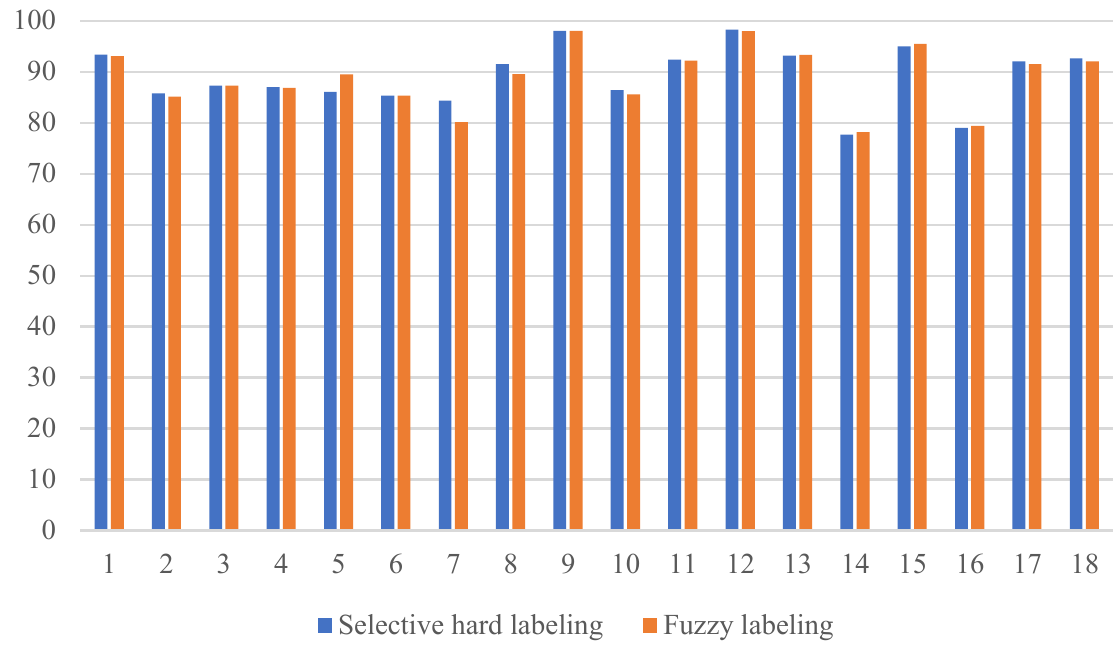
Figure 5. Performance of two labeling strategies. X-axis: tasks. Y-axis: